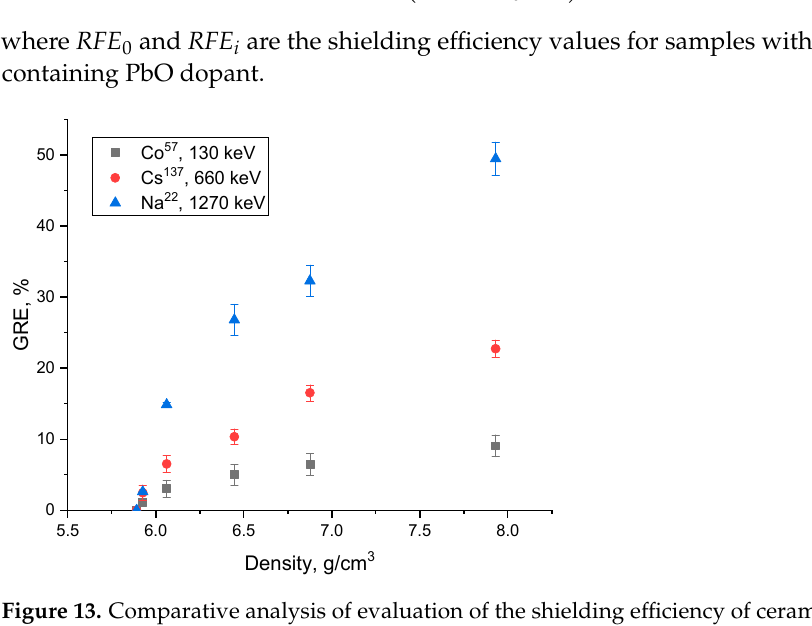
Figure 13. Comparative analysis of evaluation of the shielding efficiency of ceramics when density changes with the dopant concentration increase.